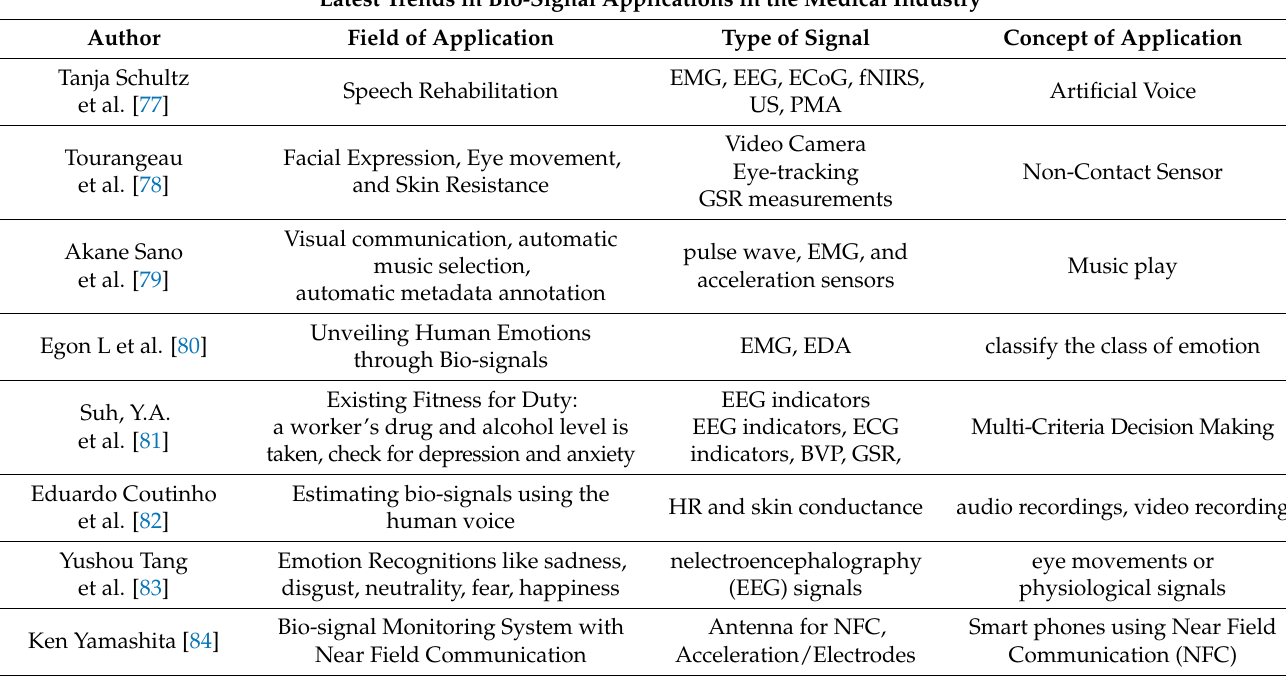
Table 6. Latest Trends in Bio-signal